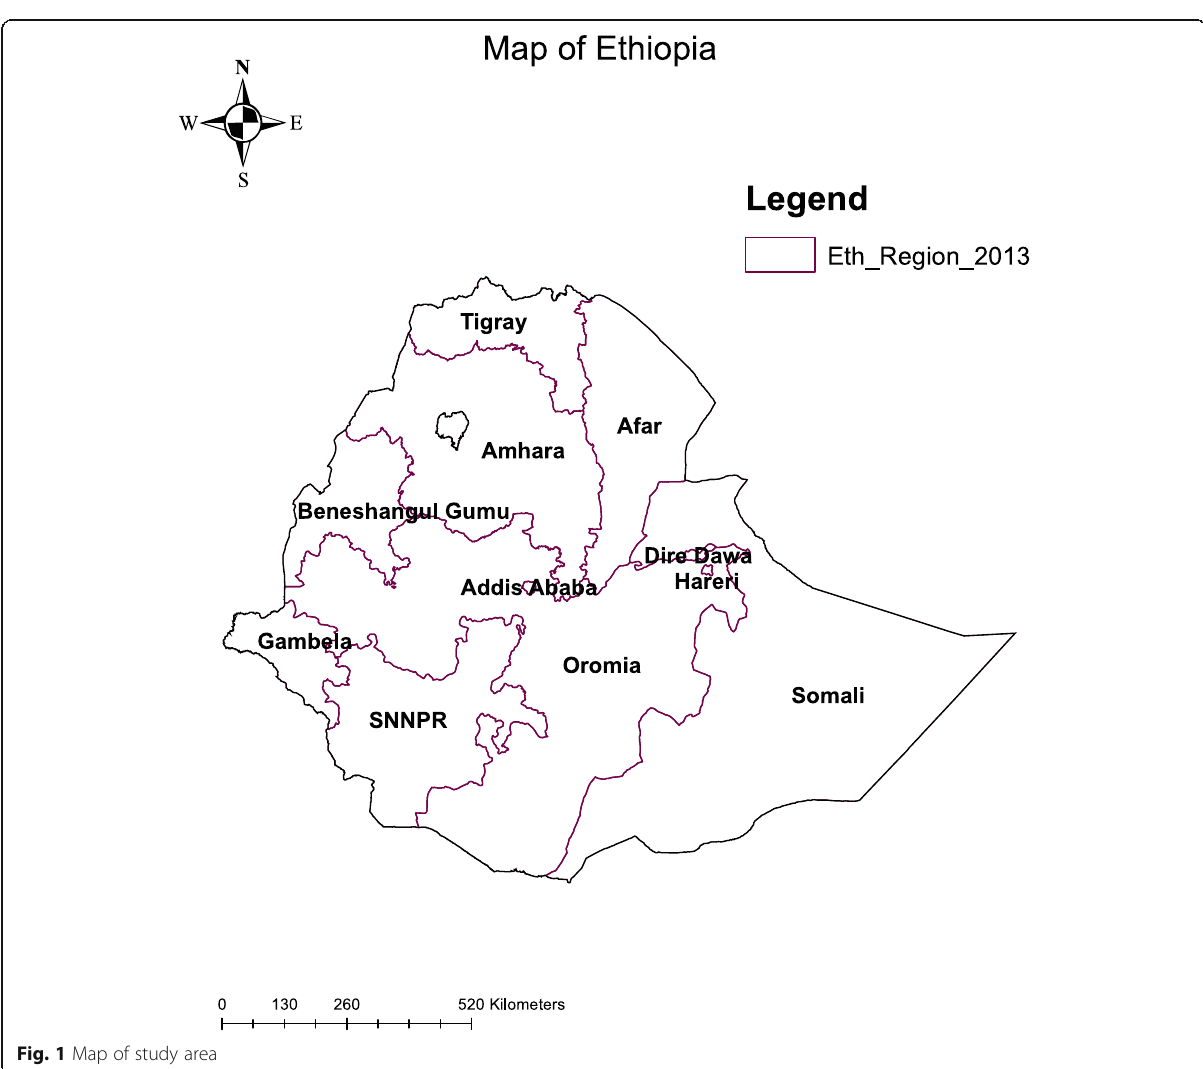
Fig. 1 Map of study